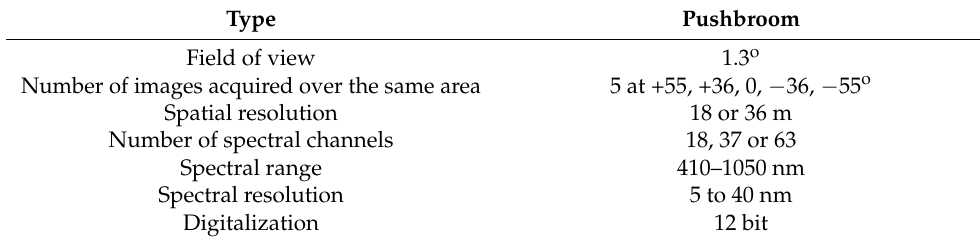
Figure 8. ( a ) Standard deviation with respect to ground truth for the retrieved reflectance of each pixels from A to H as a function of the number of iterations. The standard deviation is calculated as the root of the squared difference be- tween the retrieved reflectance spectrum and ground truth and averaged on all the values of the spectrum of each point. ( b ) Standard deviation with respect to ground truth for the retrieved reflectance of the entire image as a function of the number of iterations. Analogously to ( a ), the standard deviation is calculated as the root of the squared difference between retrieved reflectance image and ground truth but averaging both spectrally and spatially on each value of the entire datacube. Table 2. Characteristics of CHRIS sensor on board of mini-satellite